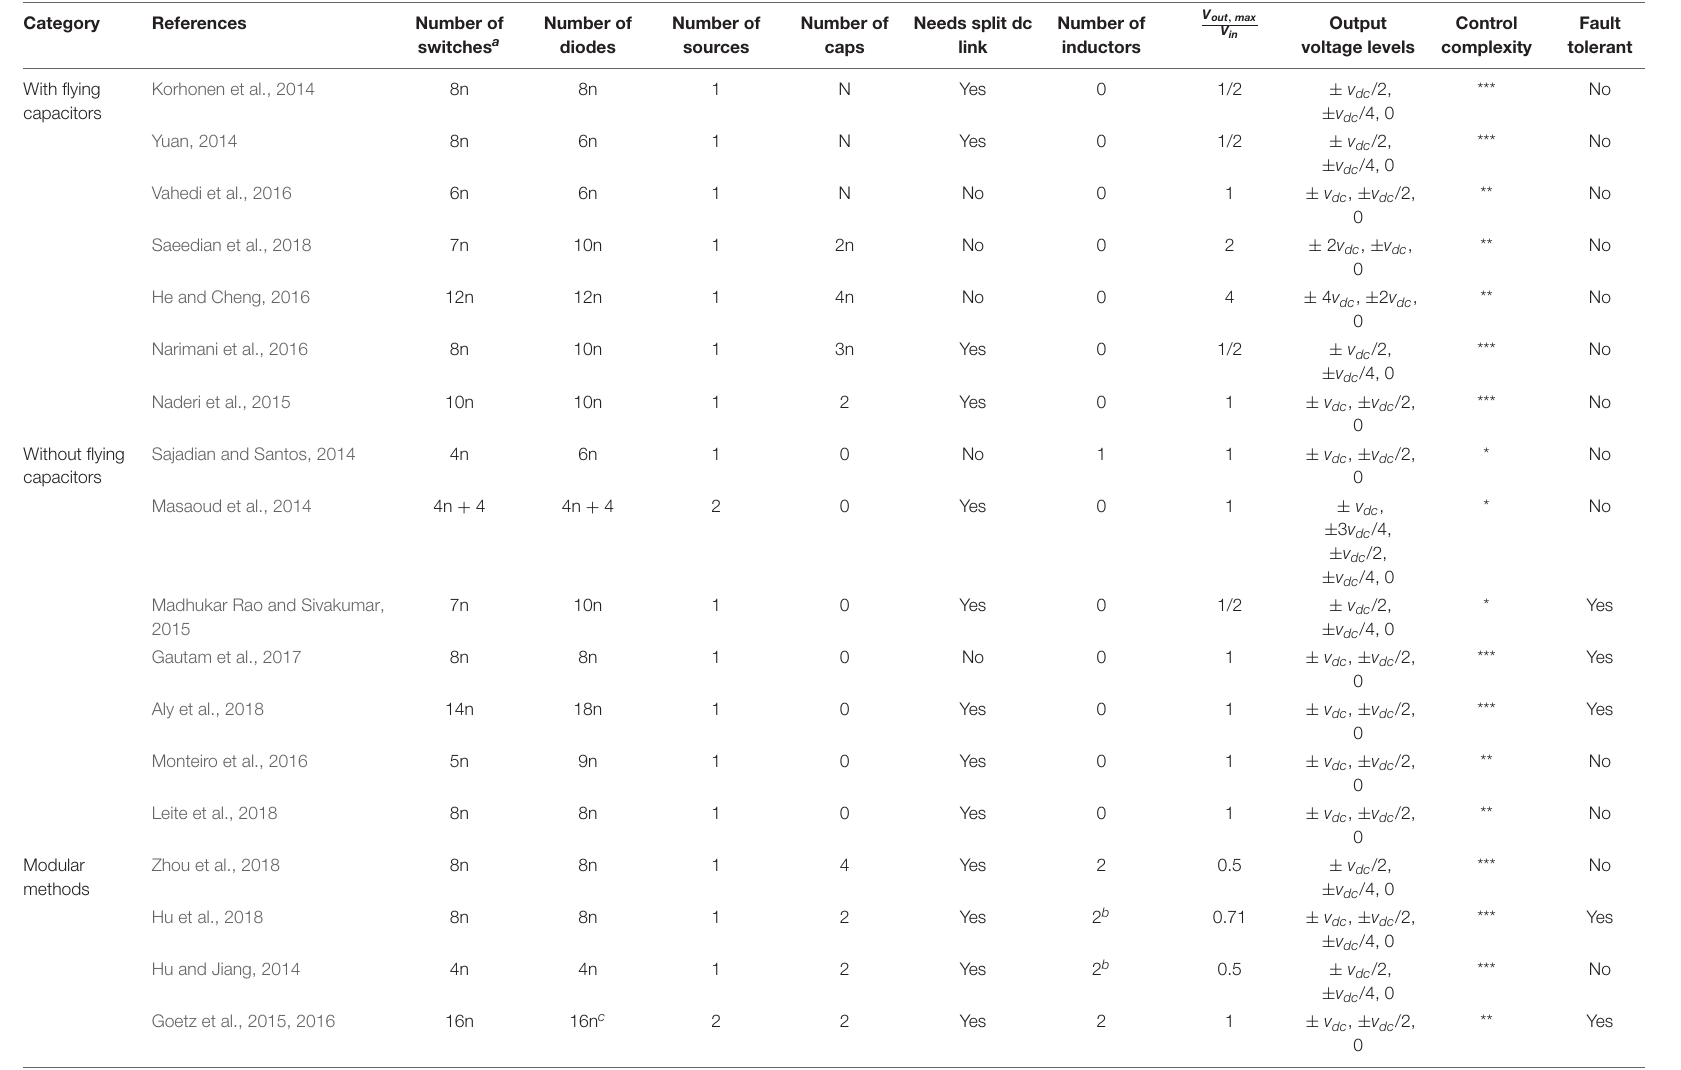
TABLE 2 | Comparison between the presented topologies.